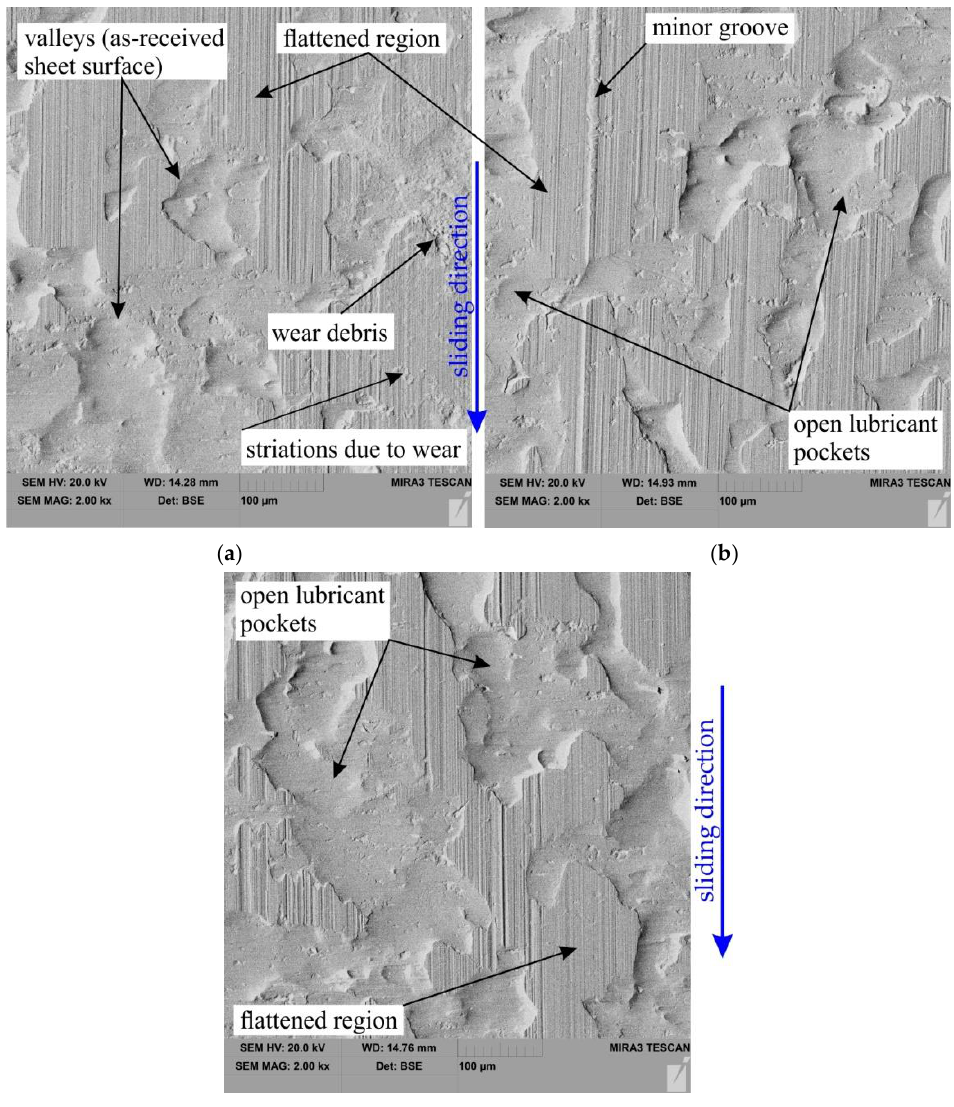
Figure 12. SEM micrographs of the sheet surface after friction tests carried out under the following conditions (nominal pressure P = 3 MPa): ( a ) dry friction, ( b ) 5W-30 oil and ( c ) 80W-90